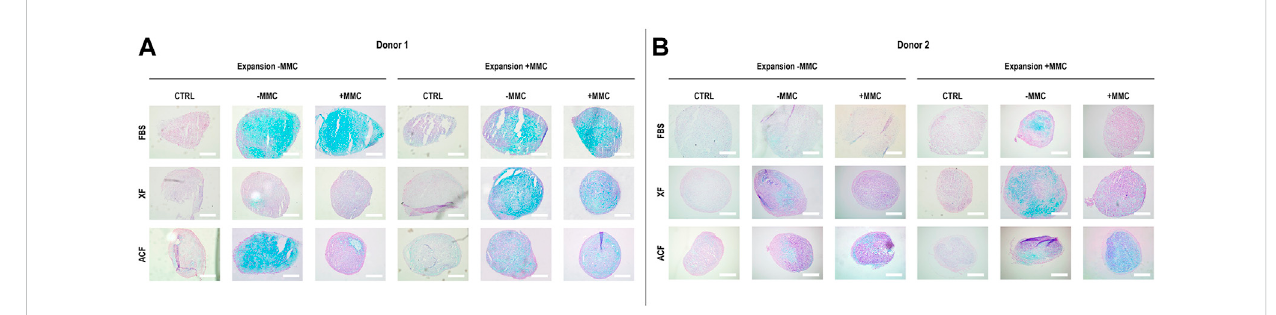
FIGURE 5 Alcian blue staining for sulphated proteoglycans of hBMSCs of donor 1 (A) and 2 (B) , expanded with or without MMC in ACF, XF and FBS containing media, and differentiated in pellet culture with chondrogenic differentiation media with or without MMC supplementation at p4. Experiments were performed in three technical